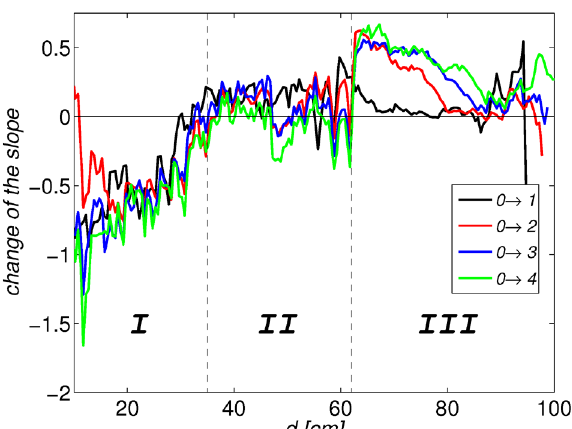
Figure 5. Change in slope compared to the initial condition with distance from the inlet. The slope has been averaged over rings of width dr = 5cm for different distances d from the inlet and then normalized with the overall mean slope. Three regions can be identified: I, II, and